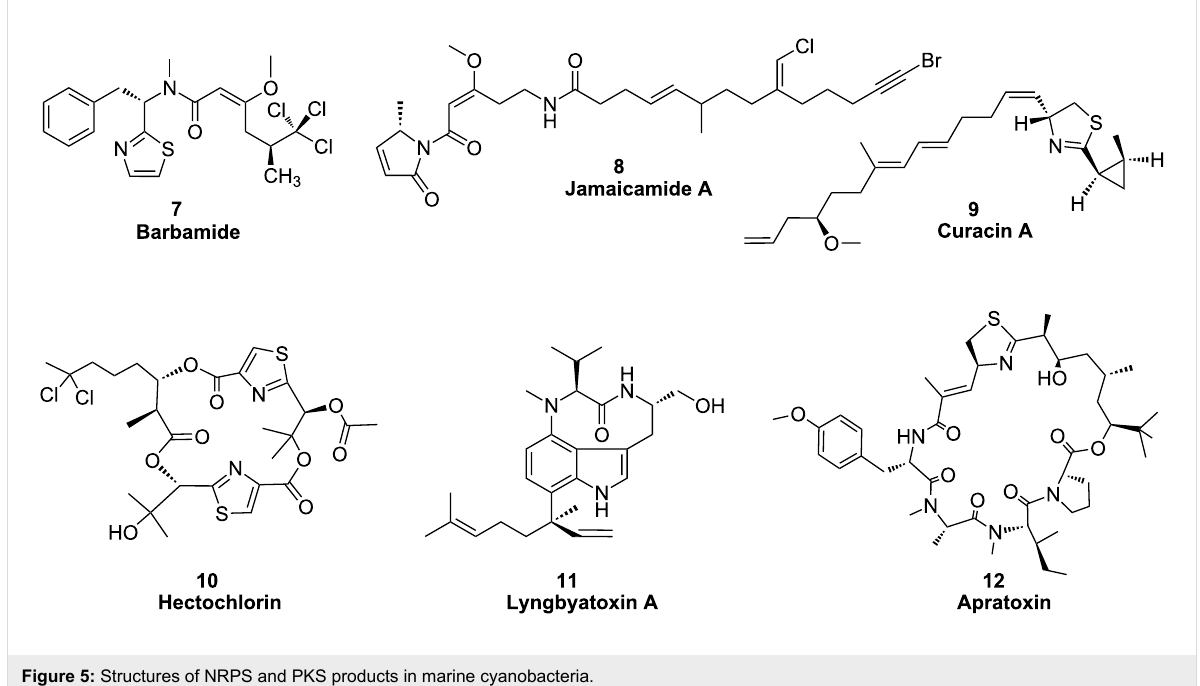
Figure 5: Structures of NRPS and PKS products in marine cyanobacteria.